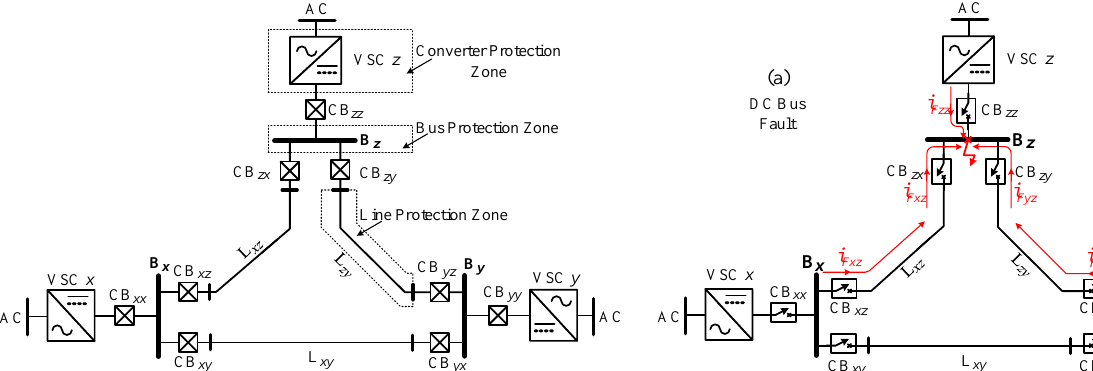
Fig. 1. BCBs arrangement in a multi-terminal HVDC grid